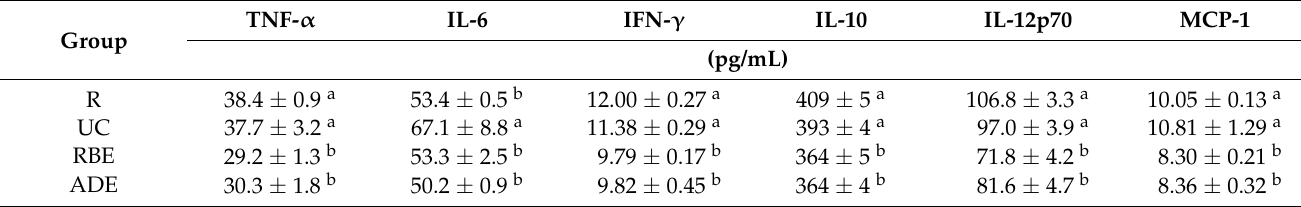
Table 3. Plasma levels of cytokines and chemokine MCP-1.